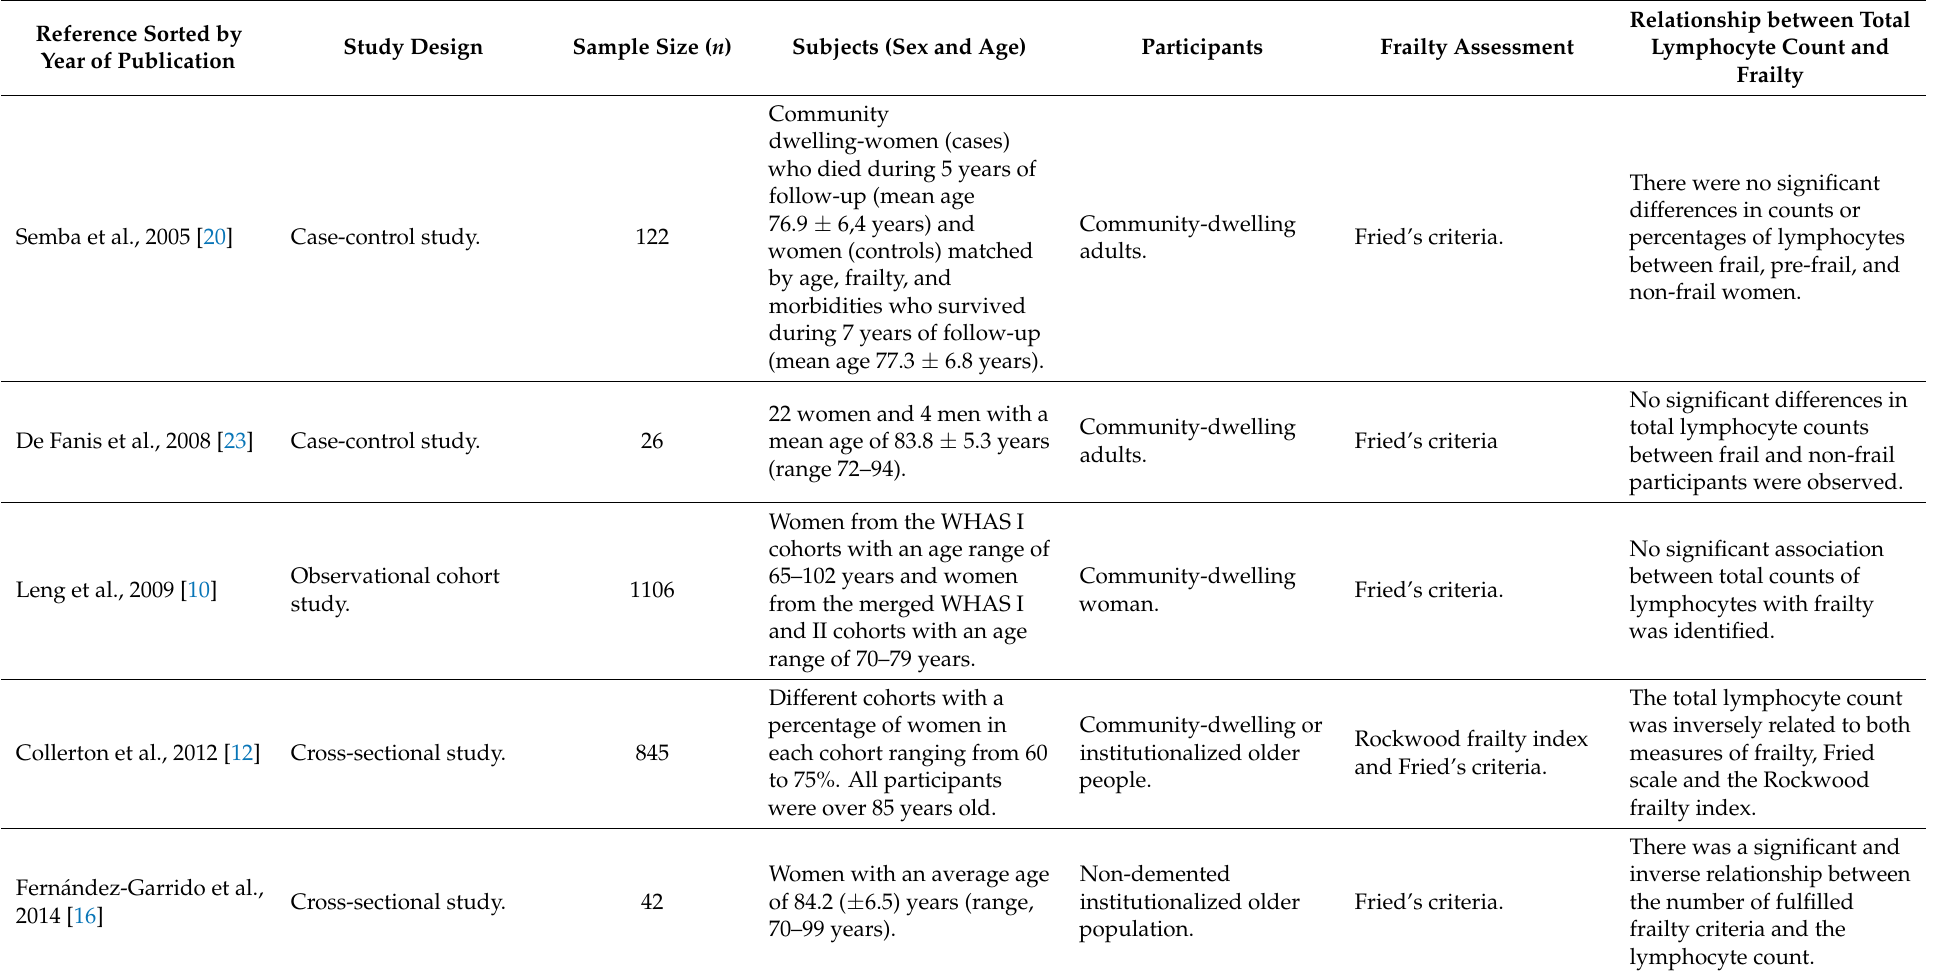
Table 1. Main characteristics of clinical studies analyzed in frailty